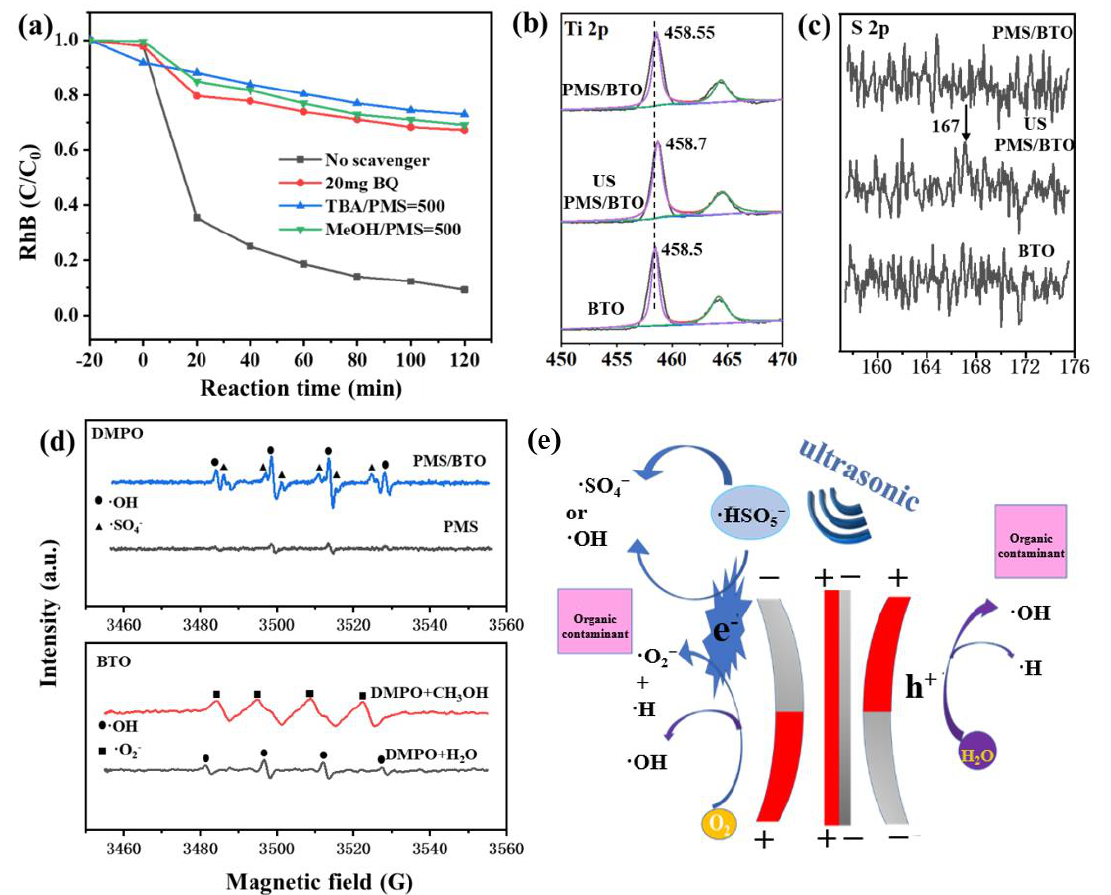
Figure 6. ( a ) The effects of different free radical inhibitors on RhB degradation. ( b ) Ti 2p; ( c ) S 2p XPS of BTO, US-PMS/BTO, and PMS/BTO. ( d ) The free radical detections of BTO, PMS, and PMS/BTO. ( e ) A schematic illustration of the PMS activation process by the BTO piezocatalyst.